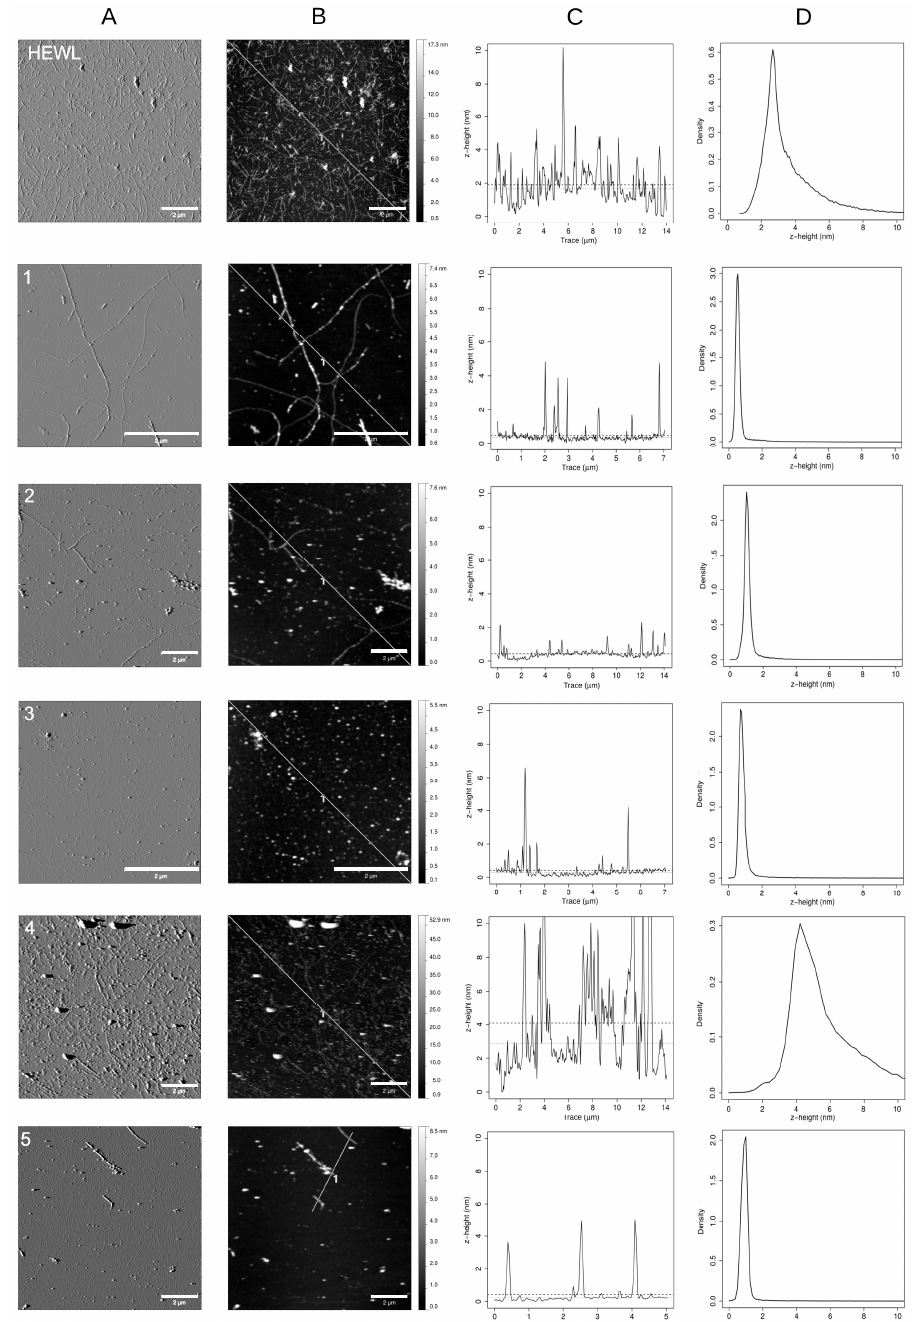
Figure 3. Atomic force microscopy (AFM) maps of HEWL incubated in aggregation conditions for 10 days in the presence or absence of the 4-thiaflavane derivatives (compounds 1 – 5 ): ( A ) amplitude maps; ( B ) morphology maps and the corresponding ( C ) profile traces, together with the mean and median z -high values plotted as horizontal dashed or dotted lines, respectively; ( D ) height distribution of the whole map. Scale bar: 2 μ m.